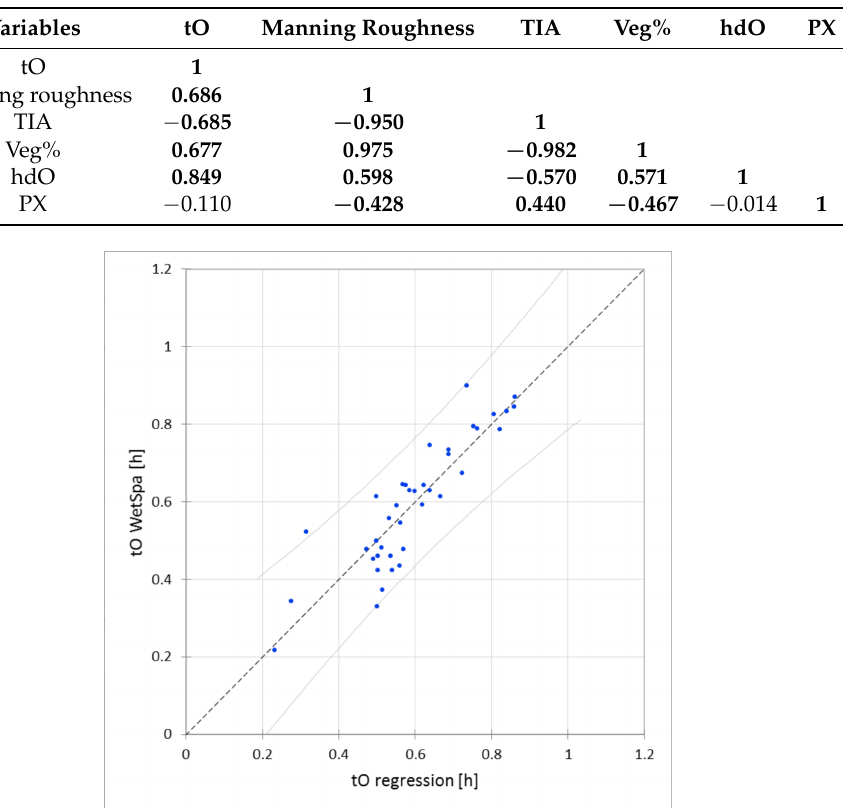
Figure 10. Timing to outlet : regression method vs. WetSpa